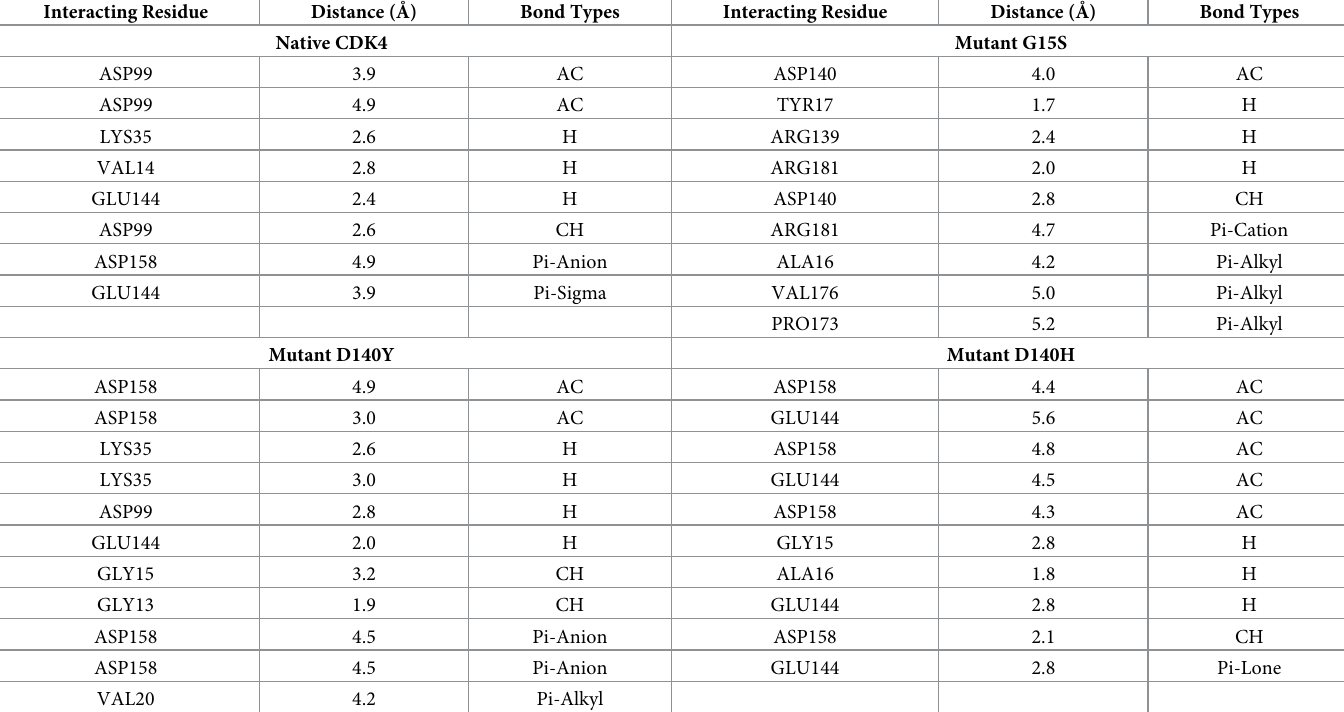
Table 3. Protein-ligand interaction analysis of native and mutant proteins with ATP ((AC = attractive electrostatic charge interaction; H = Hydrogen bond; CH = Carbon Hydrogen bond). Interacting